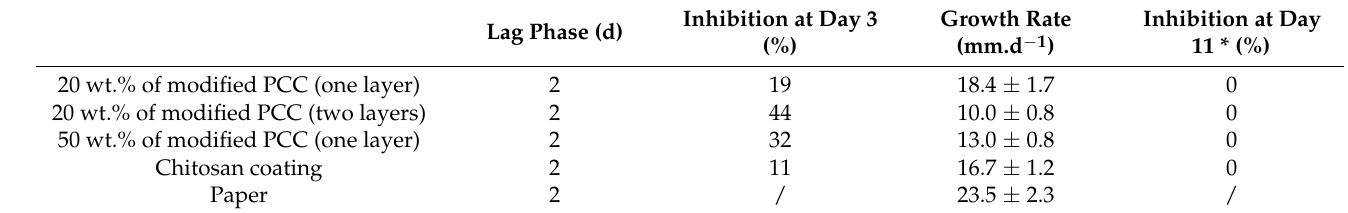
Table 8. Antifungal activity of coated paper on C. globosum (20 spores inoculated) at days 3 and 11. Inhibition percentages were given as control reference. Inhibition at Day 3 Growth Rate Inhibition at Lag Phase (d) (%) (mm.d − 1 )